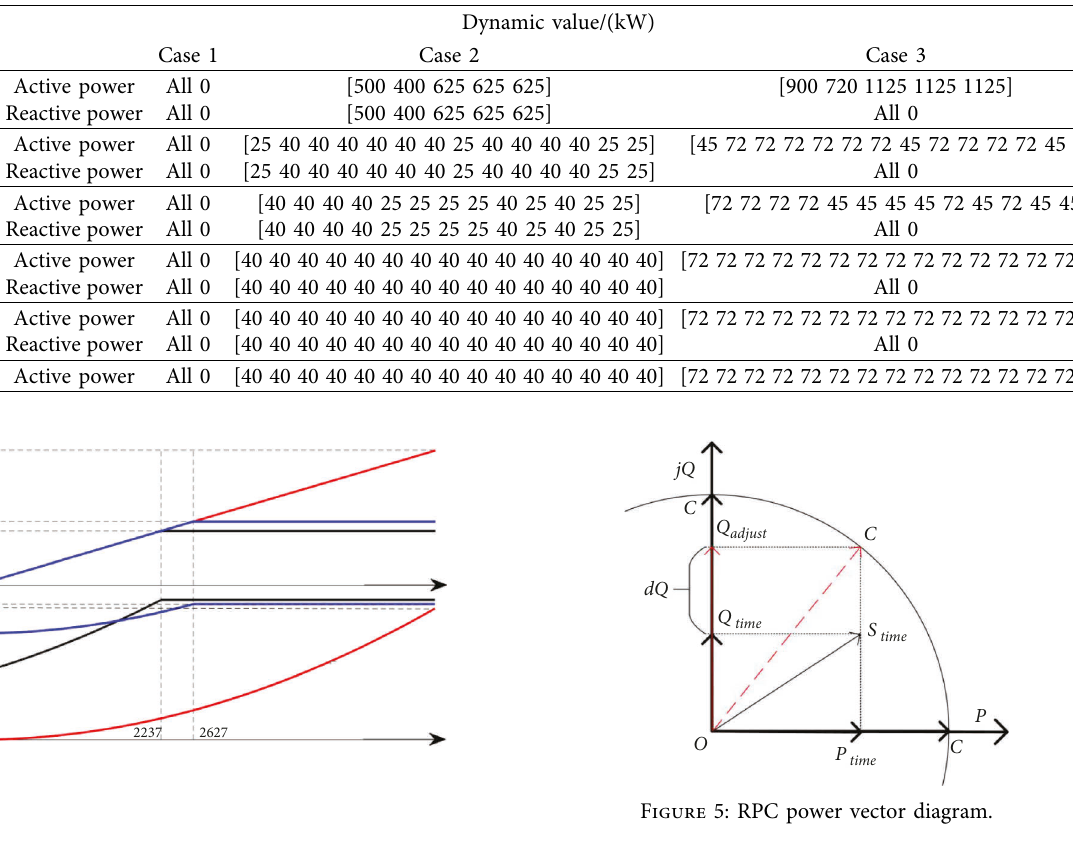
Table 4: Dynamic parameters of PVPS installation.